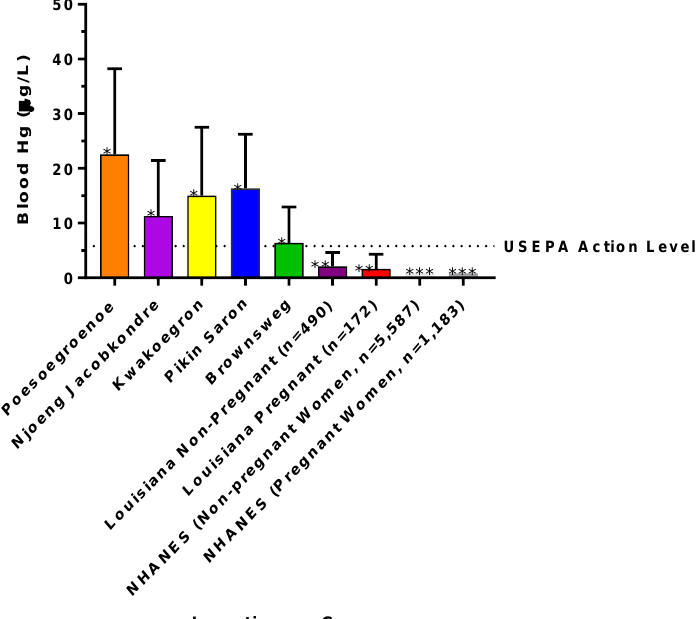
Figure 3. Estimated geometric mean concentrations (± geometric standard deviation) of mercury in blood of women and children (combined) from interior villages in Suriname. Geometric mean concentrations (± geometric standard deviation) of mercury in blood of women (pregnant or non-pregnant) from coastal southeast Louisiana, as well as those representing national averages from the NHANES are also presented for comparative purposes. The USEPA action level of 5.8 µg/L is plotted for comparison. Asterisks denote significant differences at p < 0.05.